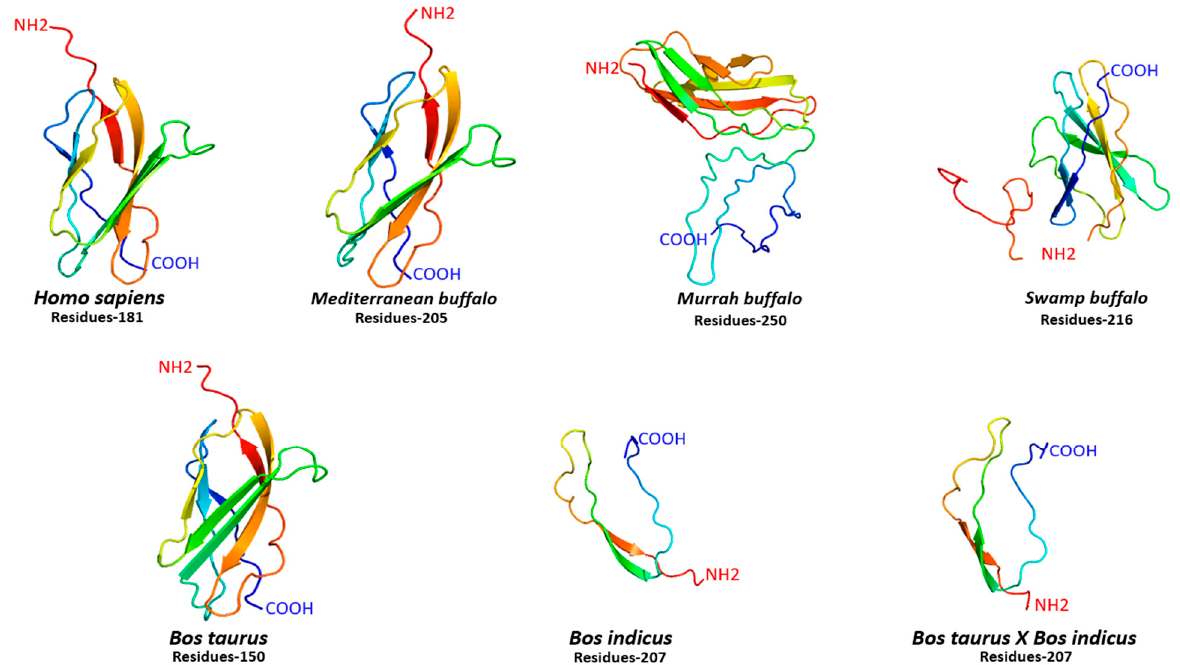
Figure 3. Three-dimensional protein configuration of FNDC5 in humans, cattle, and buffalo.